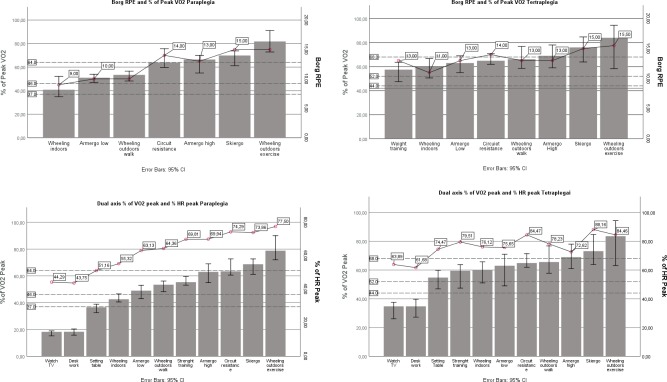
Dual axis for VO2peak (mean 95% CI) and Borg RPE or % of HRpeak during activities’, for MCT/MCP.Wheeling indoors (Borg 10–11) Km h-1, mean (range). Paraplegia 4.4 (2.9–5.8). Tetraplegia 4.2 (2.0–6.7). Wheeling outdoors (Borg 10–11) Km h-1, mean (range). Paraplegia 6.6 (4.7–8.5). Tetraplegia 5.2 (1.9–7.4). Wheeling outdoors (Borg 13–14) Km h-1, mean (range). Paraplegia 8.9 (6.3–12.0). Tetraplegia 7.6 (5.5–8.6).